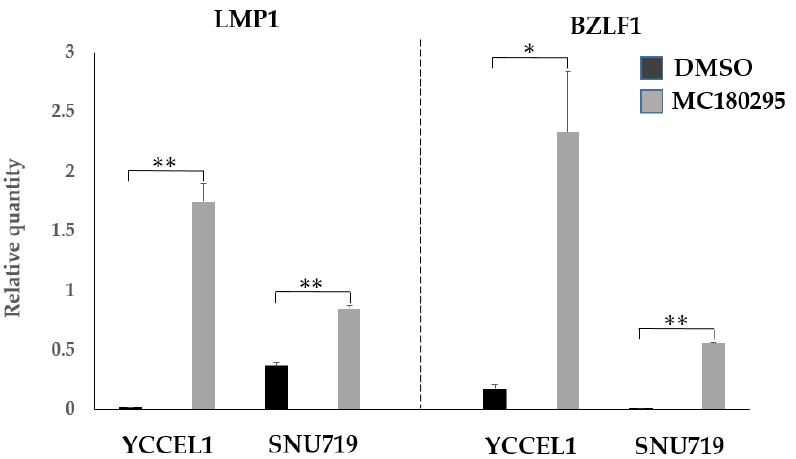
Figure 5. EBV gene expression after MC180295 treatment. The expression levels of LMP1 and BZLF1 were up-regulated in both YCCEL1 and SNU719 cells treated with MC180295. Data were obtained from three independent experiments. Bars denote SE ( n = 3), * p < 0.05. ** p < 0.01.